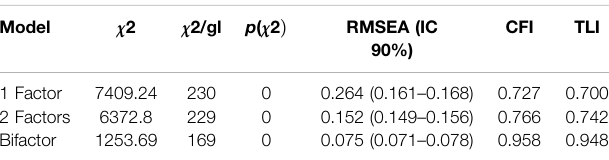
TABLE 2 | Models adjustment